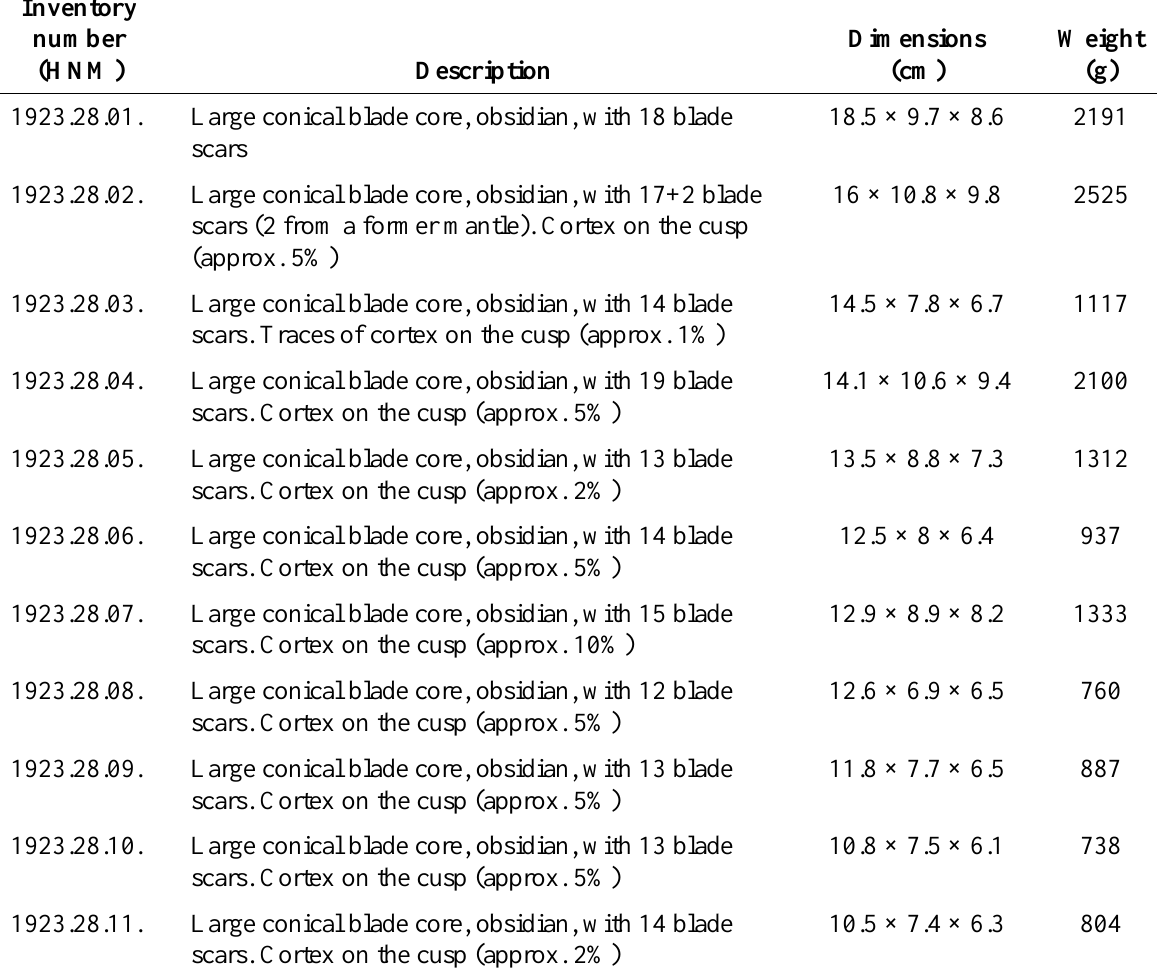
Table 1. Description and metrical data of the Nyírlugos cores.